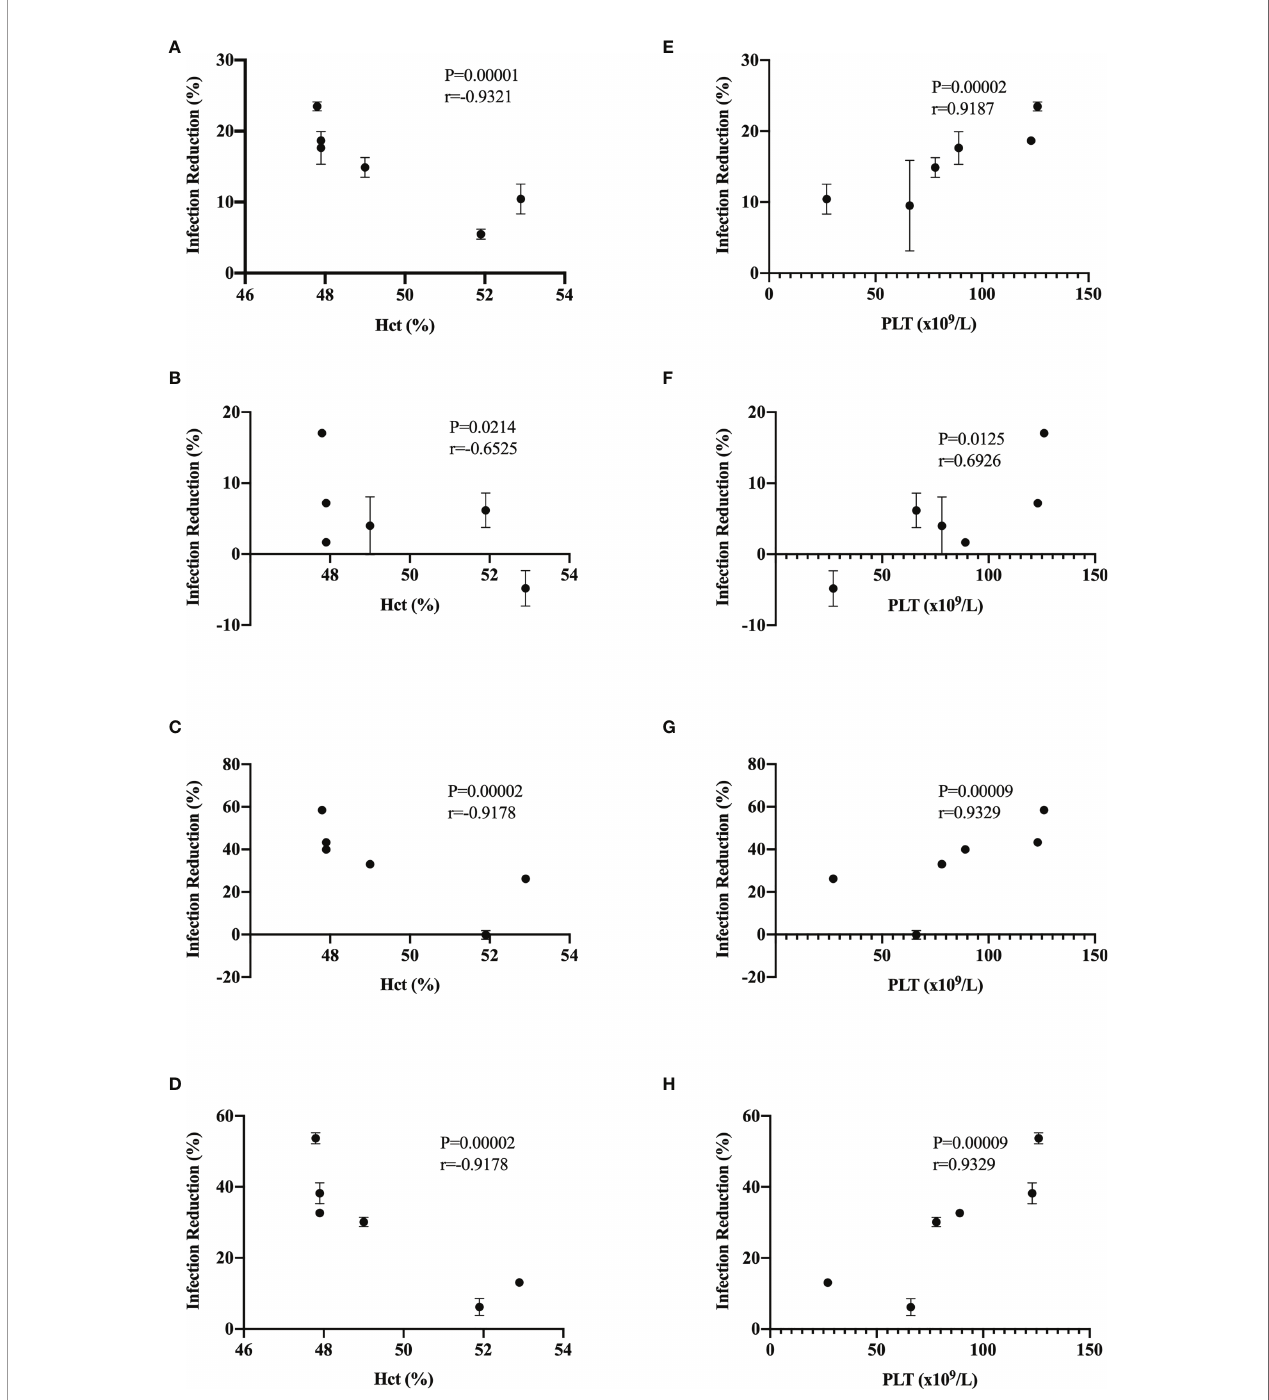
FIGURE 5 | Correlation of infection reduction with warning signs. Spearman ’ s correlation was calculated between infection reduction percentages in Vero cells preincubated with 10 IU/mL of recombinant universal type I interferon and percentages of hematocrit at 1 dpi (A) and 2 dpi (B) and with 100 IU/mL recombinant universal type I interferon and percentages of hematocrit at 1 dpi (C) and 2 dpi (D) . Spearman ’ s correlation was calculated between infection reduction percentages in Vero cells preincubated with 10 IU/mL of recombinant universal type I interferon and platelet count at 1 dpi (E) and 2 dpi (F) and with 100 IU/mL of recombinant universal type I interferon and percentages of hematocrit at 1 dpi (G) and 2 dpi (H)